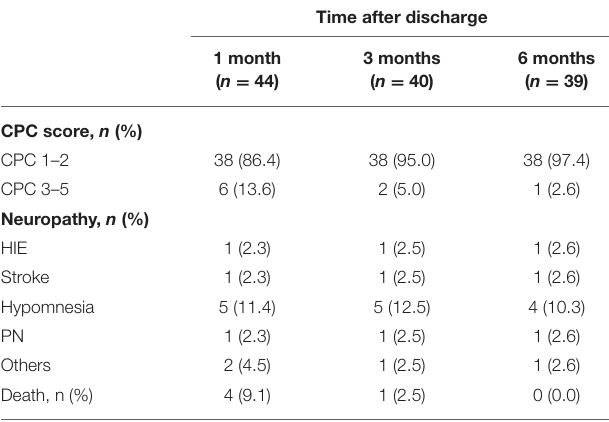
TABLE 4 | Long-term neurological outcomes of survivors after